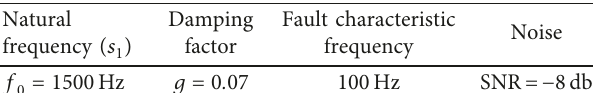
Figure 1: Frequency-band division using the 1/3-binary tree filter bank. Table 1: Parameters of the simulation